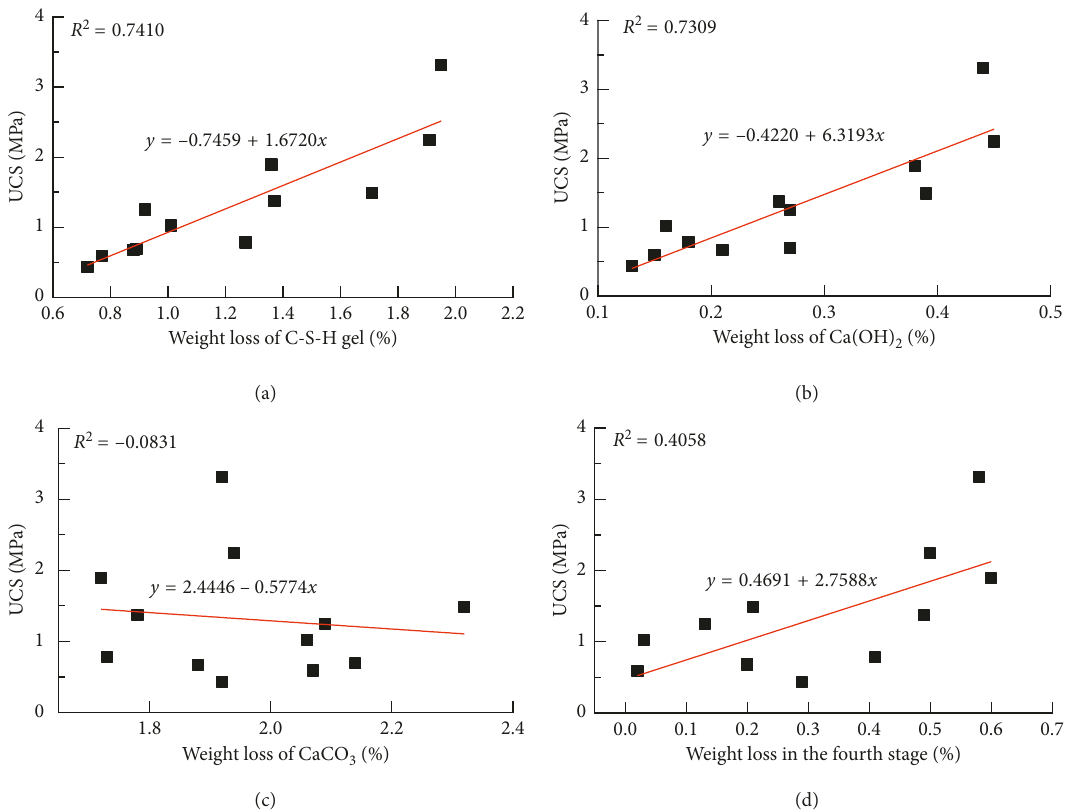
Figure 11: Fitting diagrams of weight losses of hydration products and strength of OPC-CTB (mass concentration 70%): (a) fitting diagram of weight loss of C-S-H gel and UCS of OPC-CTB; (b) fitting diagram of weight loss of Ca(OH) 2 and UCS of OPC-CTB; (c) fitting diagram of weight loss of CaCO 3 and UCS of OPC-CTB; (d) fitting diagram of weight loss in the fourth stage and UCS of OPC-CTB. Table 4: Relationship model of strength and weight losses of hydration products. Type of